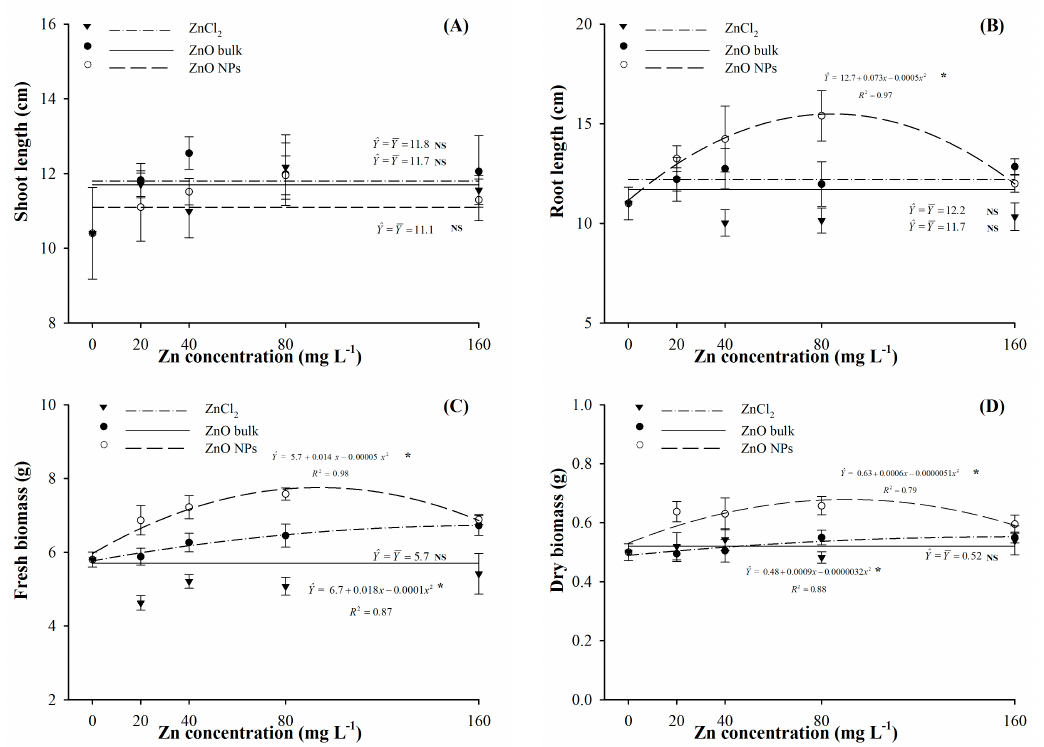
Figure 4. Seedling shoot length ( A ), root length ( B ), fresh biomass production ( C ), and dry biomass production ( D ) of corn after different concentrations and sources of Zn. * = significant at 5% of probability by regression test. NS -non-significant at 5% of probability by regression test.